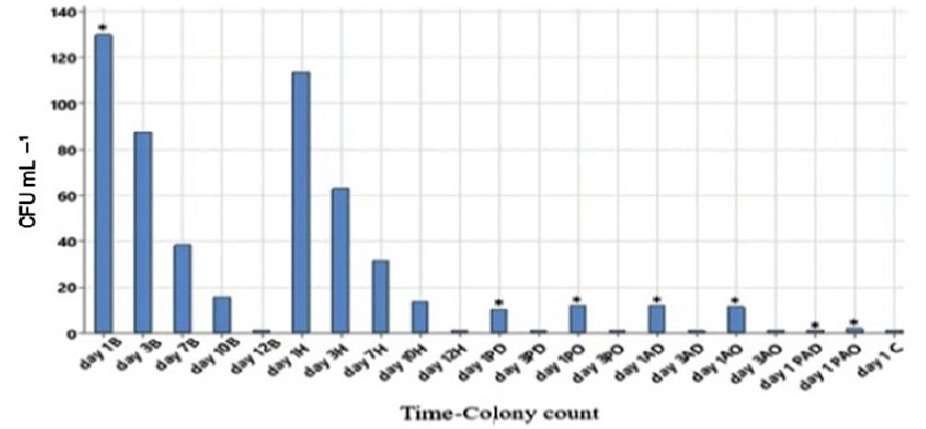
Figure 12. Bacterial load in different mouse groups on days 1, 3, 7, 10 and 12. C: Control, B: Untreated infectious, H: Hydrogel, PD: Phage (daily), PO: Phage (once), AD: Antibiotic (daily), AO: Antibiotic (once), PAD: Phage-Antibiotic (daily), PAO: Phage-Antibiotic (once). * p < 0.001 means significant relative to untreated infectious group.